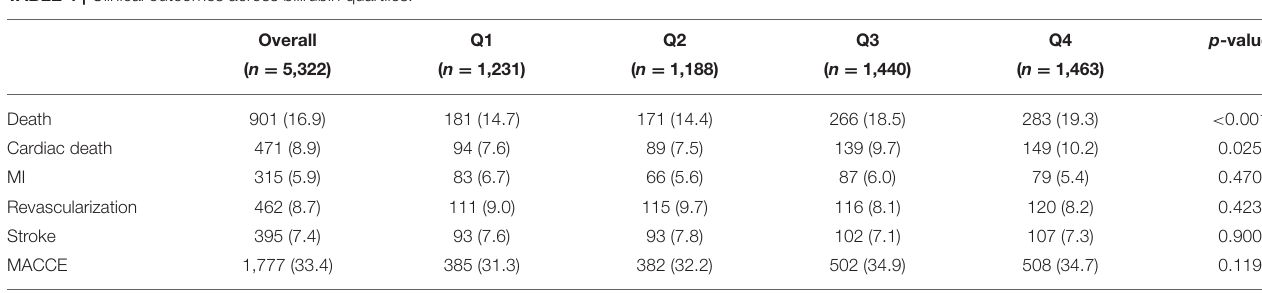
TABLE 4 | Clinical outcomes across bilirubin quartiles.